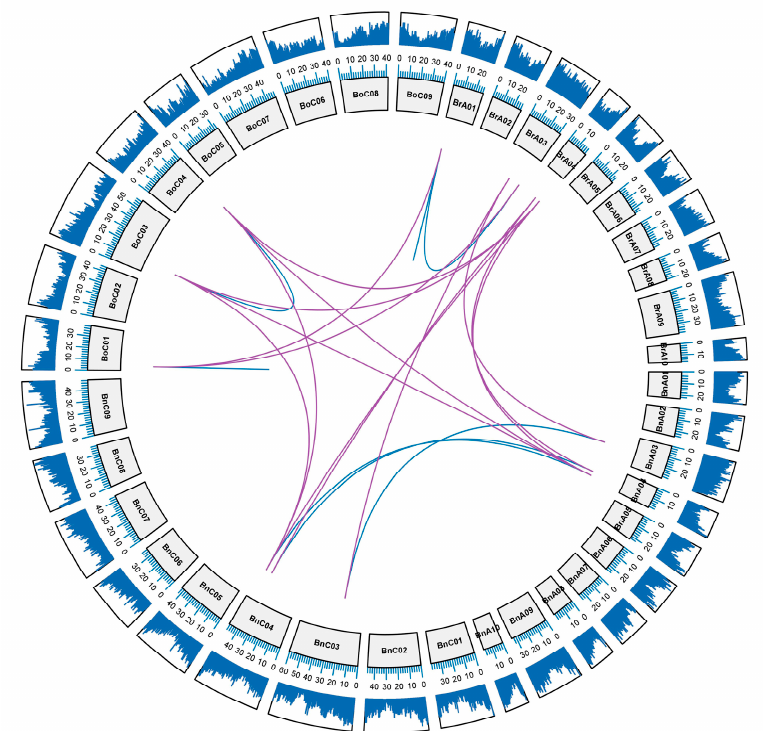
Figure 3. Genome-wide synteny analysis of A n and C n subgenome in B. napus , and A r genome in B. rapa , and C o genome in B. oleracea . Blue lines in the figure represented the paralogous genes and purple represented orthologous genes. The outer ring was gene density on chromosome. The inner circle was the chromosome name and its length scale.